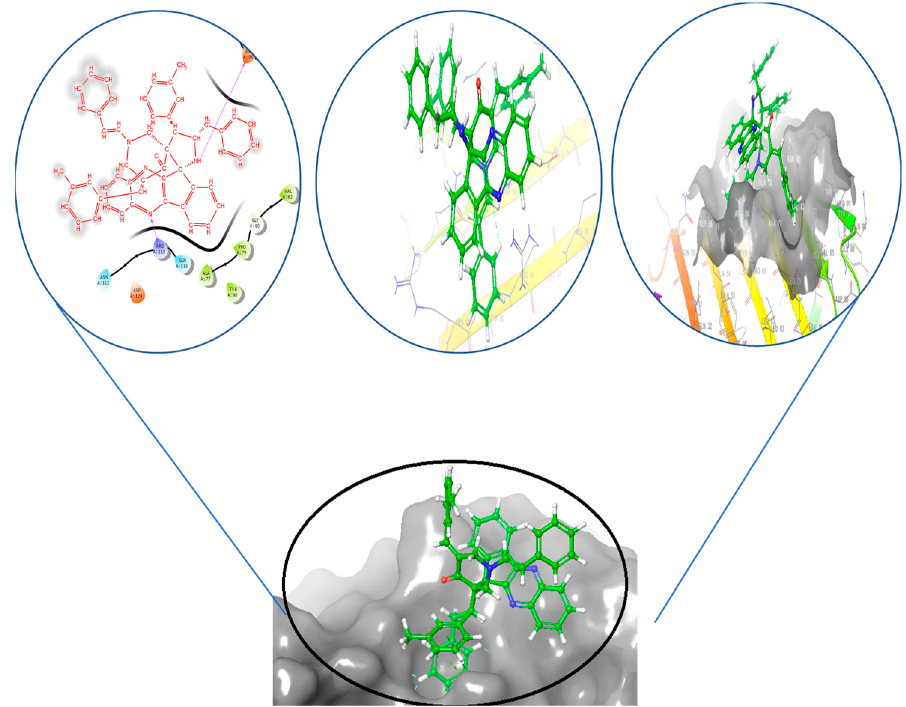
Figure 6. Molecular docking conformation of compound 8h into the bacterial outer membrane protein (1IWN) protein binding pocket. Table 4. Molecular docking data of compound 8h with bacteria outer membrane (1IWN) protein receptor.